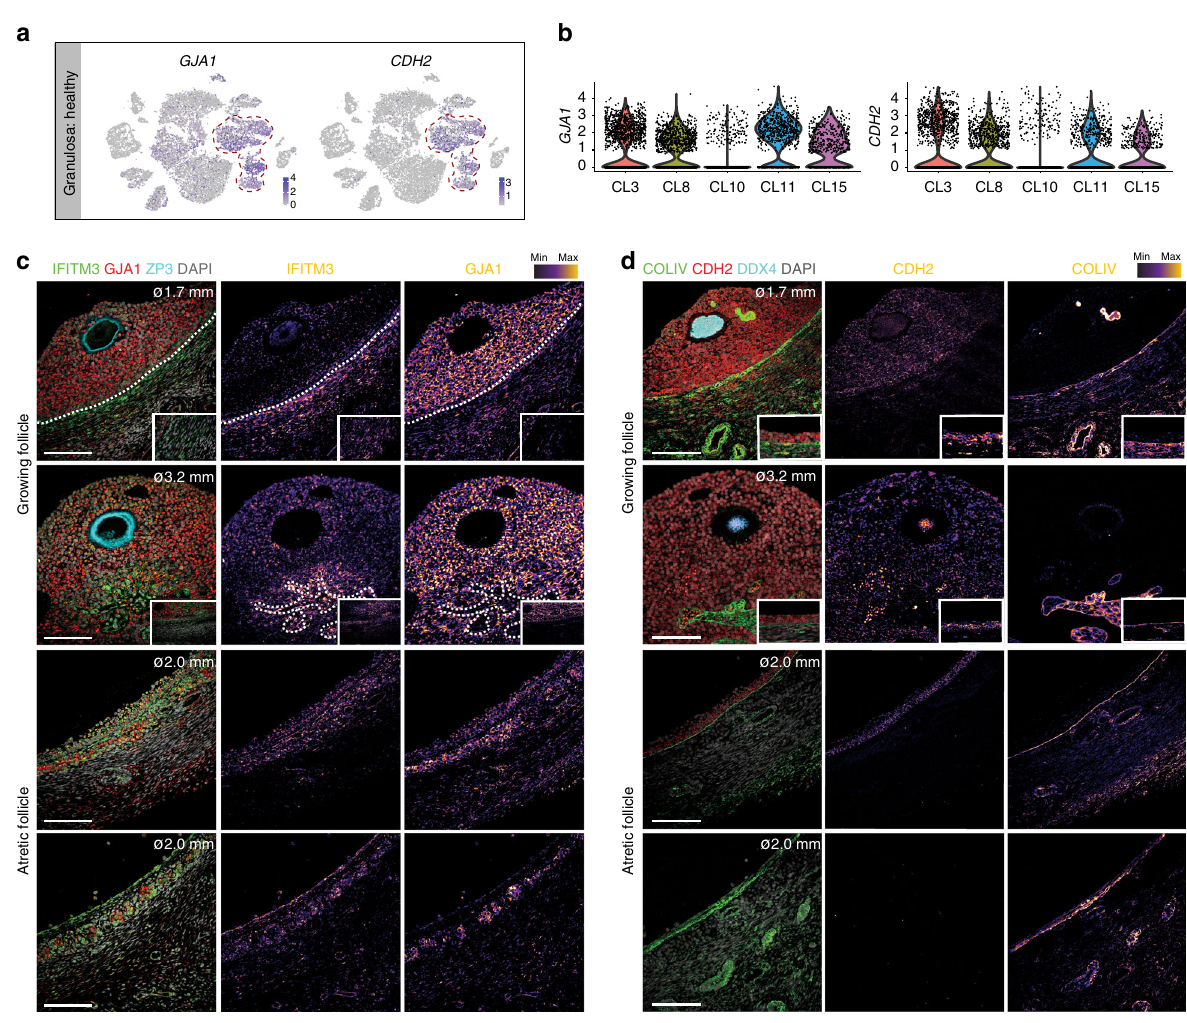
Fig. 5 Granulosa cells in early atretic follicles. a tSNE cluster map showing expression of selected genes downregulated in CL10, but not on the other granulosa cell (GC) clusters. Red dashed lines give the boundaries of expression. b Violin plots showing expression levels of GJA1 and CDH2 in the different clusters of GC. c Immunostaining of follicles (ø, diameter) growing (top two rows) and atretic (bottom two rows) for IFITM3, GJA1, and ZP3. Inset shows mural GC of the same follicle with same magni fi cation. Single channel images were converted to an intensity map. White dotted line marks the basement membrane. Scale bars are 100 μ m. d Immunostaining of follicles (ø, diameter) growing (top two rows) and atretic (bottom two rows) for CDH2, COLIV, and DDX4. Inset shows mural GC of the same follicle with same magni fi cation. Single channel images were converted to an intensity map. Scale bars are 100 μ